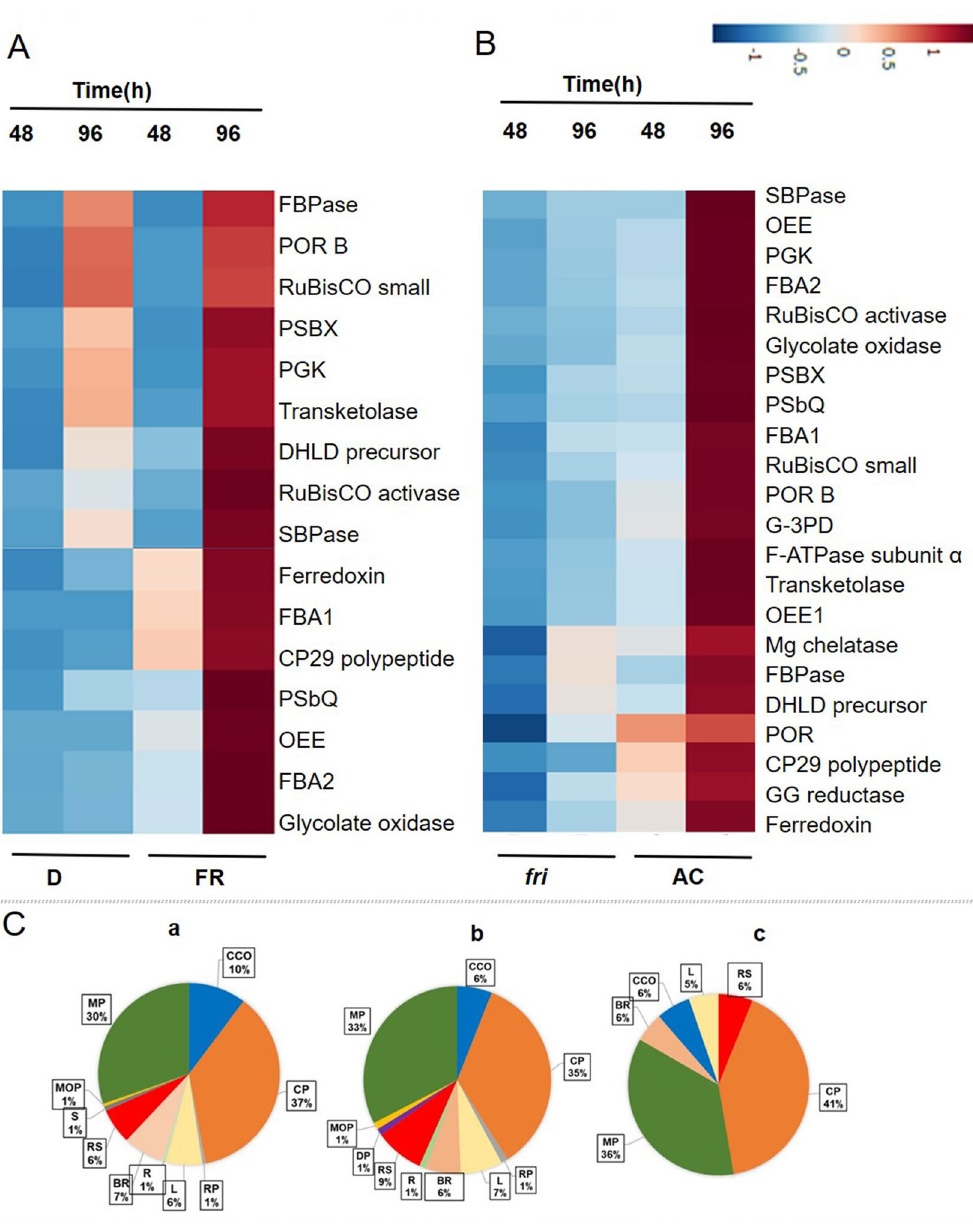
Figure 2. Quantitative proteomics to understand the role of PhyA in the light-mediated establishment of the photosynthetic machinery. ( A ) Heat map illustrating the fold ratio of differentially altered proteins in the central carbon metabolic pathways in response to FR irradiation in AC seedling in comparison to dark-grown AC control. ( B ) Heat map demonstrating the fold ratio of differentially altered proteins in the fri mutant in comparison to AC seedlings under FR irradiation. OEE1-33 kDa precursor protein of oxygen-evolving complex; OEE-The oxygen-evolving enhancer protein; DHLD precursor-dihydrolipoamide dehydrogenase precursor; RuBisco-ribulose-1,5bisphosphate carboxylase or oxygenase; PGK-phosphoglycerate kinase; G3PD: glyceraldehyde-3-phosphate dehydrogenase; SBPase- Sedoheptulose 1,7-bisphosphatase; Mgprot IX-Mg-protoporphyrin IX chelatase; GG reductase-Geranylgeranyl reductase; Por-light dependent NADH:protochlorophyllide oxidoreductase 1; PorB-light dependent NADH:protochlorophyllide oxidoreductase 3 s2; FBA1-Fructose-bisphosphate aldolase 1, FBA2-Fructose-bisphosphate aldolase; F ATPase subunit α-ATP synthase subunit alpha; PsbX-psbX photosystem II 23 kDa protein; PsbQ-photosystem II oxygen-evolving complex protein; ( C ) The GO terms identified for biological process (a) in all the identified proteins (b) significant proteins identified in the comparison of Dark vs FR in Ailsa craig (c) significant proteins identified in the comparison of Ailsa craig vs fri mutant grown under FR light. CCO (cellular component organization or biogenesis), CP (cellular process), RP (reproductive process), L (localization), BR (biological regulation), R (reproduction), RS (response to stimulus), DP (developmental process), MOP (multicellular organismal process), MP (metabolic process) and S